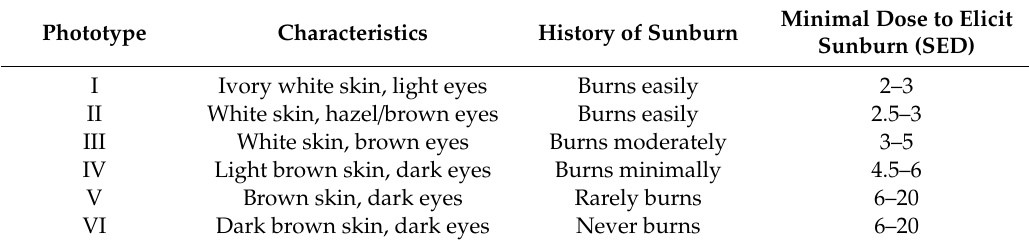
Table 1. Fitzpatrick skin phototype classification